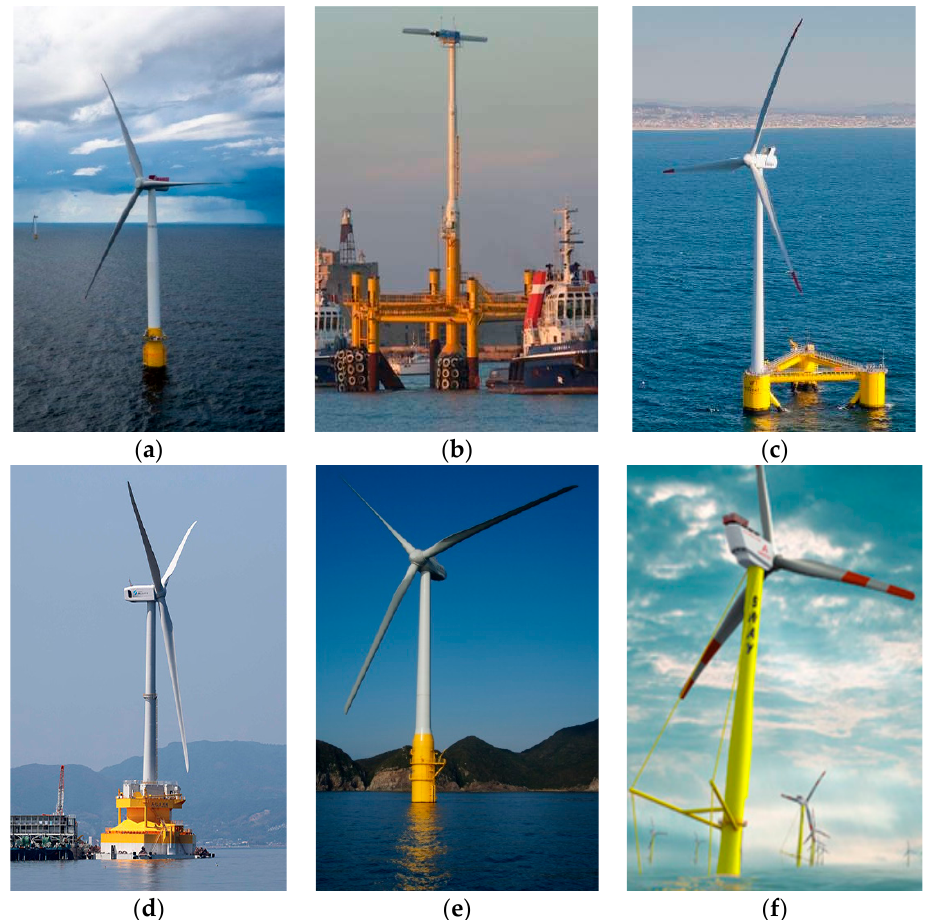
Figure 2. Typical Floating Offshore Wind Turbines. ( a ) Hywind [7]; ( b ) Blue H [8]; ( c ) WindFloat [7]; ( d ) Fukushima [9]; ( e ) GOTO [10]; ( f ) Sway [11].